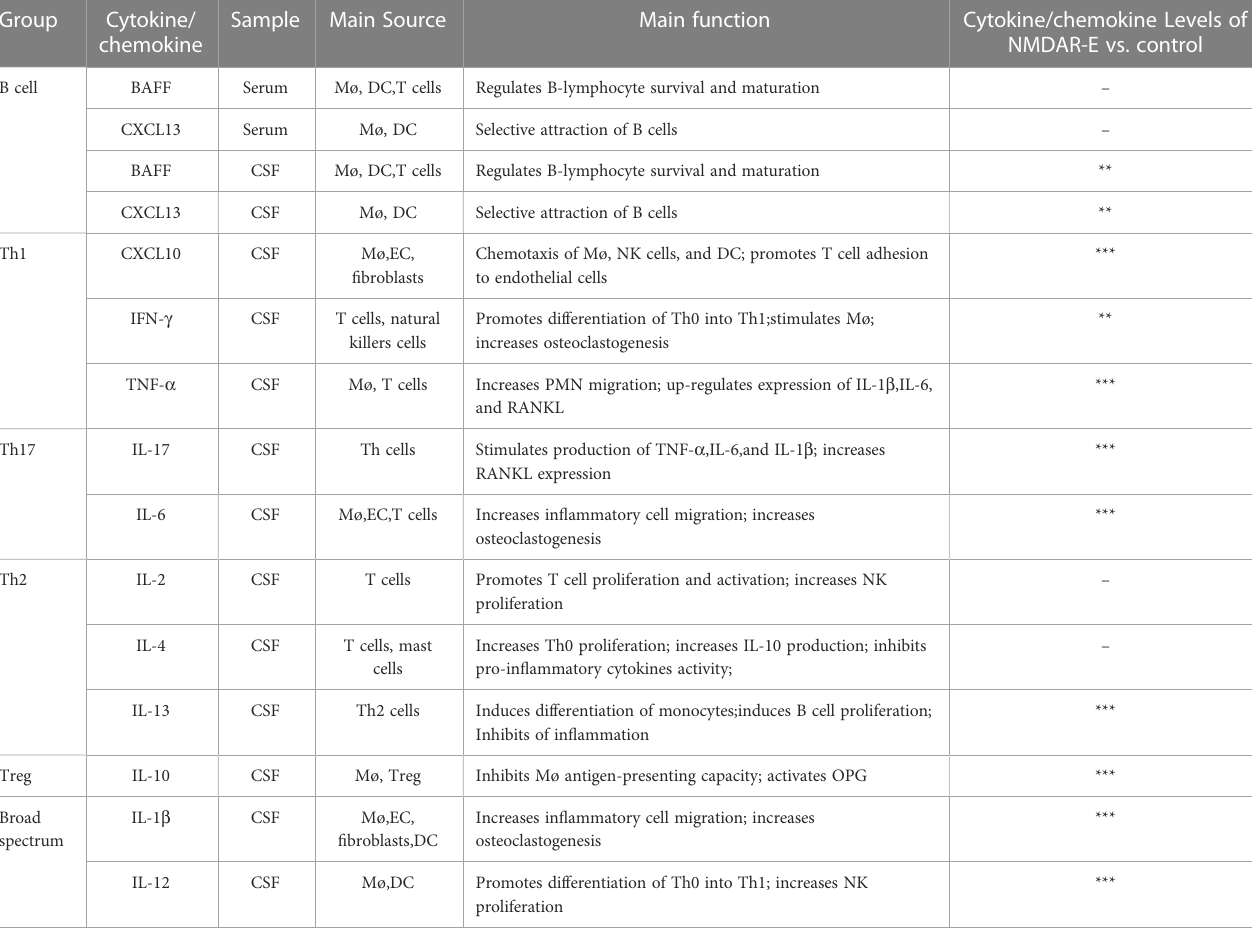
TABLE 2 Summary of the CSF/serum levels of the cytokines/chemokines in NMDAR-E vs. control subjects. Group Cytokine/